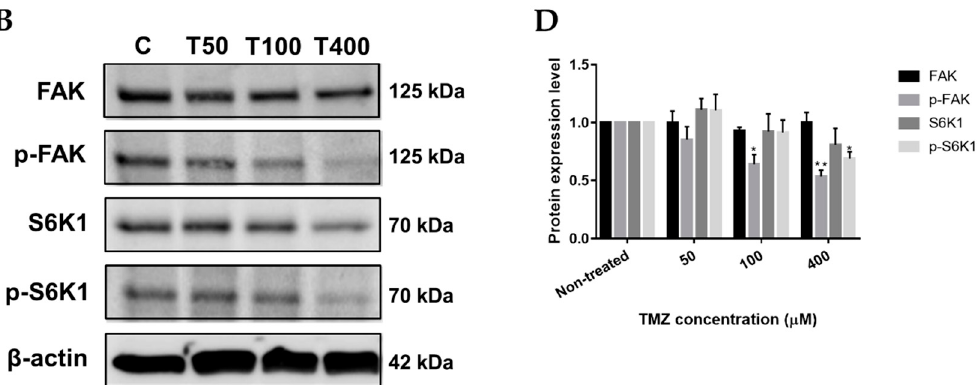
Figure 3. Neferine inhibits FAK, p-FAK, S6K1, and p-S6K1 protein levels in human neuroblastoma cells. ( A , B ) IMR32 cells were incubated with the desired concentrations of neferine ( A ) or TMZ ( B ) for 24 h. Then, all cells were harvested and lysed for Western blot analysis; ( C , D ) Changes in the levels of FAK, p-FAK, S6K1, and p-S6K1 proteins after being normalized to the levels of beta actin were presented. Data are shown as mean ± SD of three independent experiments. * p < 0.05, ** p < 0.01 as compared with the non-treated control.